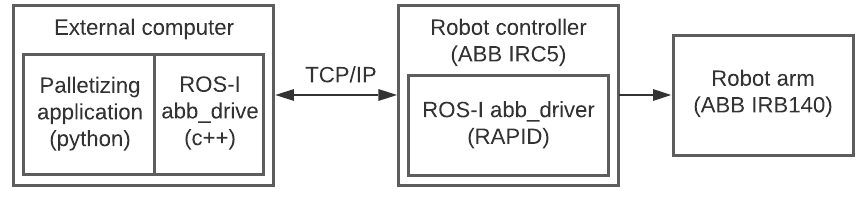
Figure 8. Block diagram for controlling the ABB IRB 140 robot arm from the ROS